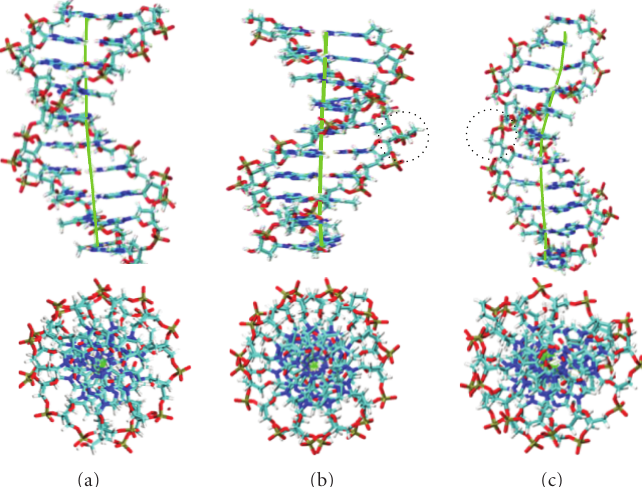
Figure 6: Side and top views of B-type duplex produced by molecular dynamics simulations, the double-helix axes are outlined in green. (a) Unmodified dA 10 /dT 10 ODNref , (b) dA 10 /dT 4 TxT T 4 ODNgm with TxT = ( R C 5 (cid:2) , S P ) α , β -D-CNA TT, or (c) ODNgp with TxT = ( S C 5 (cid:2) , R P ) α , β -D-CNA